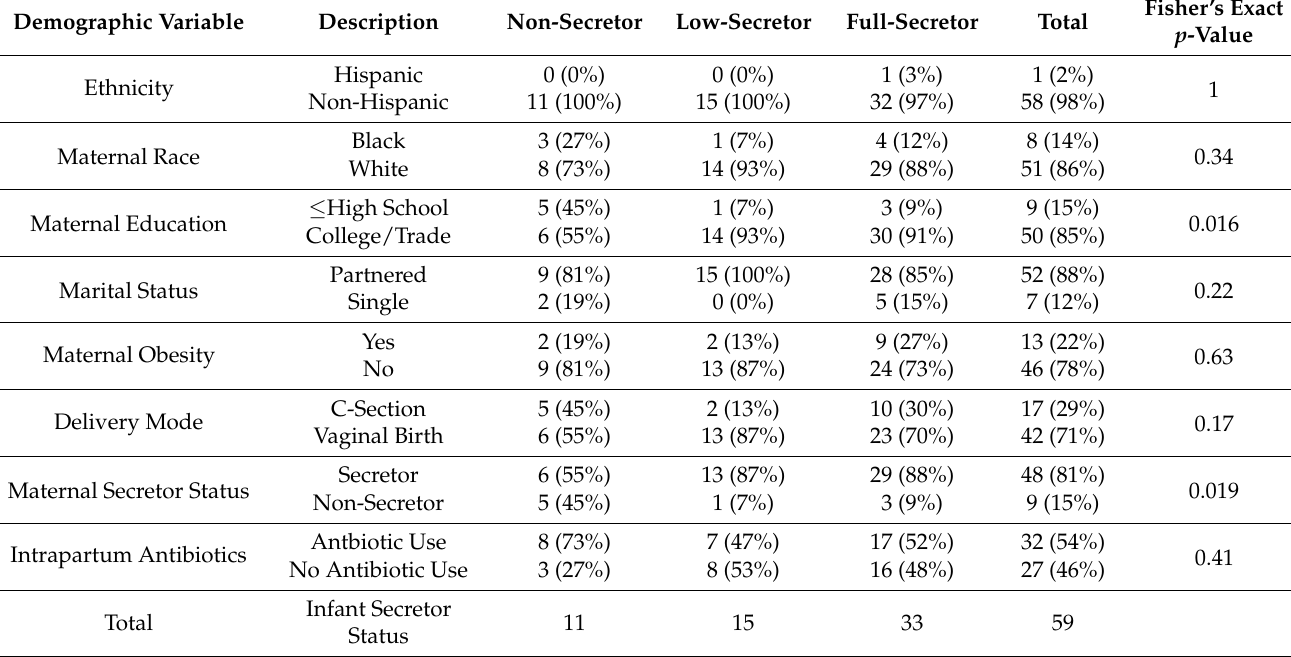
Table 1. Demographics of the exclusively breastfeeding dyads of the PREVAIL